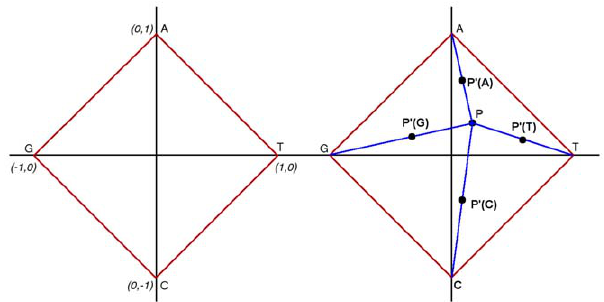
Figure 1. W-curve nucleotide coordinate positions (left) and W- curve projection of each nucleotide (right). The W-curve is generated using a square centered at the origin with corners on the axes (left). Each moving point moves halfway from a starting point P to P’ halfway to the corner for the next base in sequence (right). The numbers iterate within the square as follows: P’(T)=[(Px + 1)/2, (Py)/2]; P’(A)=[(Px)/ 2, (Py + 1)/2]; P’(G)=[(Px–1)/2], (Py)/2]; P’(C)=[(Px)/2, (Py–1)/2]